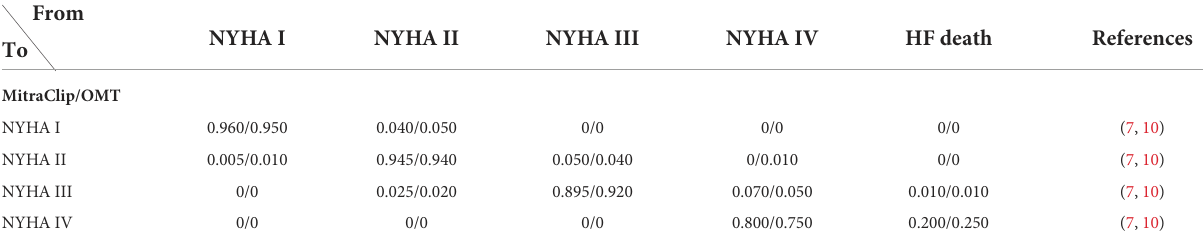
TABLE 1 Transition between NYHA classifications in MitraClip and OMT